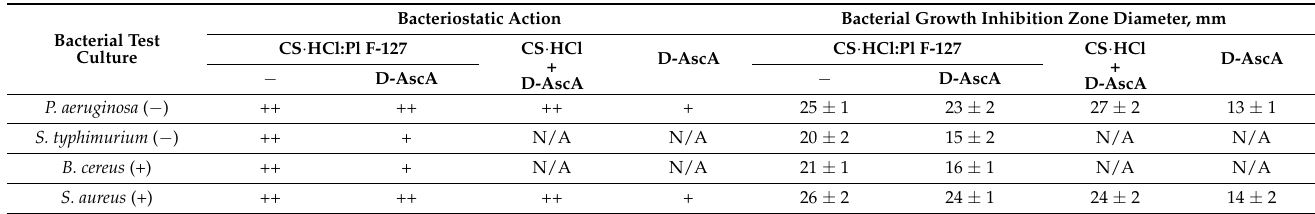
Table 2. Antibacterial activity of our thermosensitive CS · HCl:Pl F-127 = 30:70 (vol./vol.) hydrogels with C CS · HCl = 3 wt.%, C Pl F-127 = 25 wt.%. without and with the addition of D-AscA,